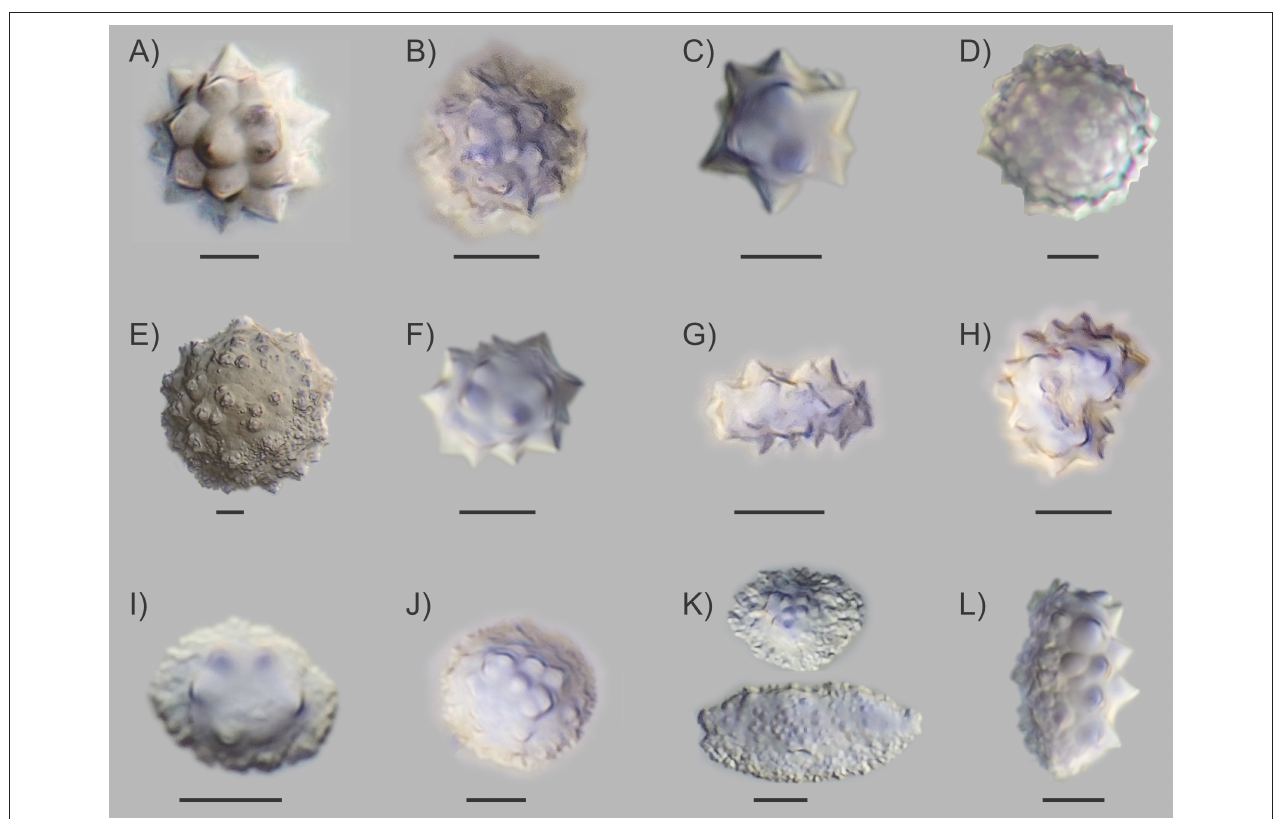
FIGURE 1 | Phytolith morphotypes identified from herbarium material of species that are found in mid-elevation Andean forests (A) globular echinate variant 1: regularly arranged projections; (B) globular echinate variant 2: crowded projections; (C) globular echinate variant 3: irregular projections; (D) globular echinate variant 4: short, bold projections; (E) large globular granulate; (F) globular echinate elongate variant 1: elliptical; (G) globular elongate variant 2: straight; (H) reniform echinate variant 1: thick; (I) conical variant 1: few (3–6) projections arranged around the top; (J) conical variant 2: many (8–20) projections arranged densely on top; (K) conical variant 3: flat or plateaued, projections arranged randomly on top surface; (L) conical variant 4: with basal projections. The scale bar for each phytolith is 5 µ m in